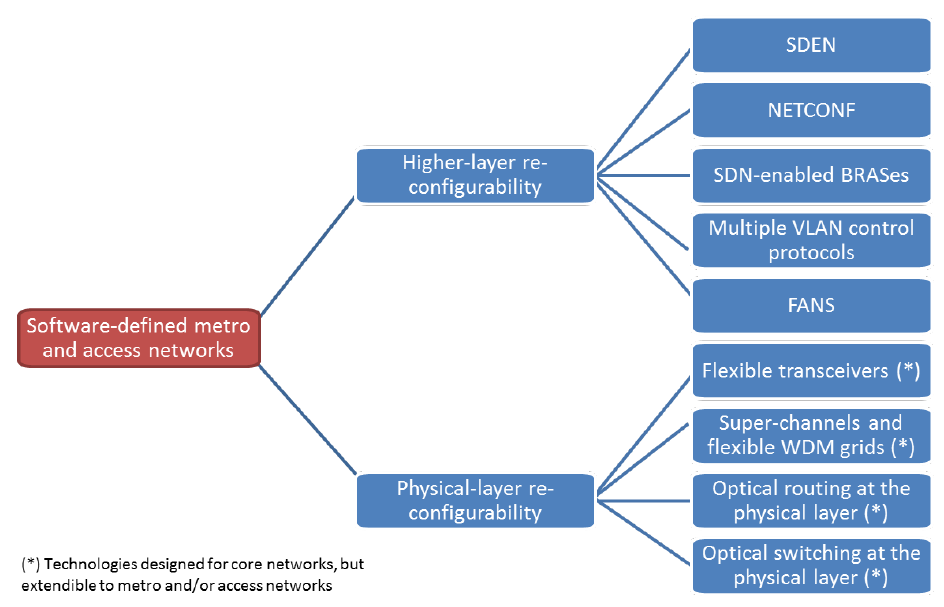
Figure 5. Main solutions for software-defined metro and access networks.